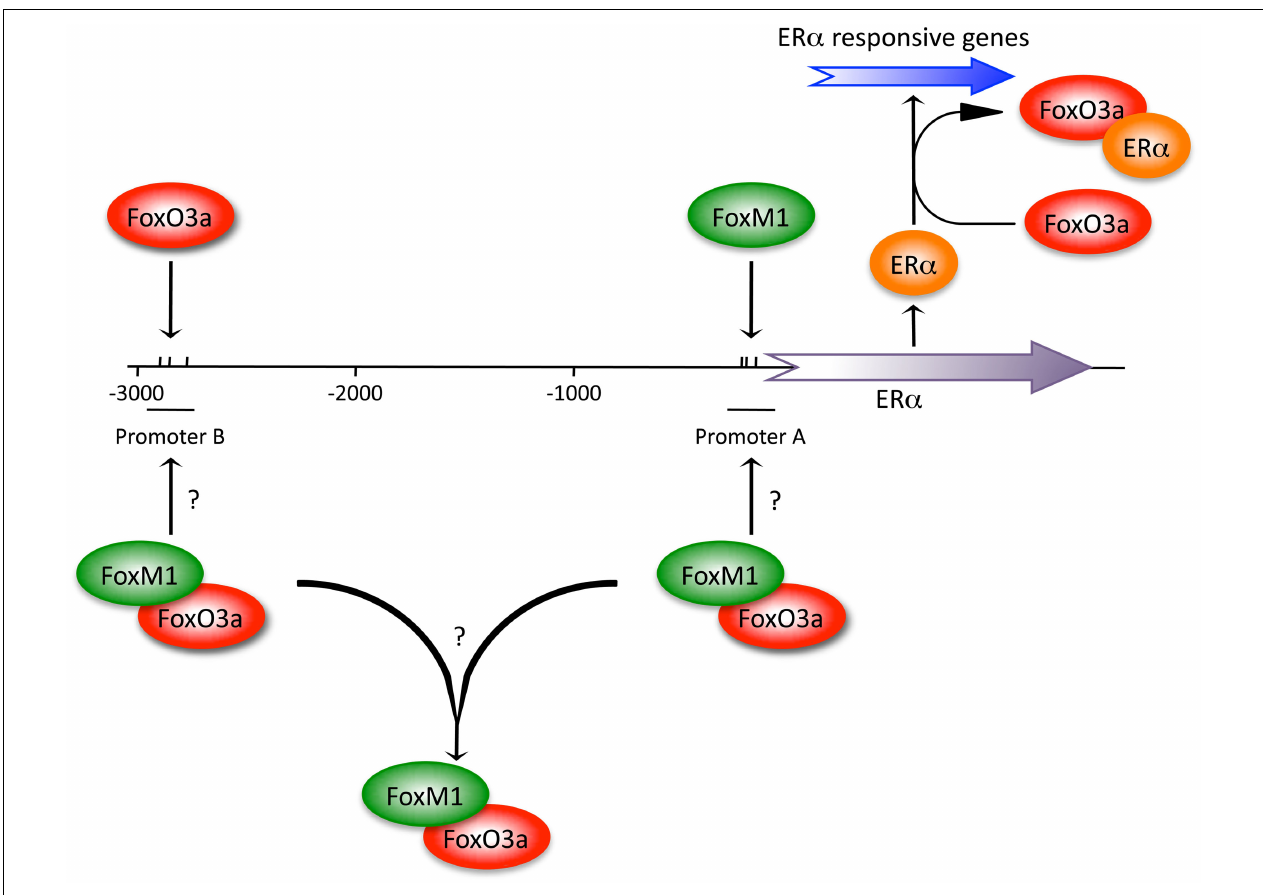
with FoxM1 playing a dominant role. A second level of complexity involves a protein/protein interaction between FoxO3a and ER α that blocks ER α from promoting the transcription of ER α responsive genes. A potential FoxO3a/FoxM1 physical interaction provides a third possible layer of complexity.The relevance of the FoxO3a/FoxM1 interaction remains unknown.This figure is based on work by Zou et al. (2008) and Madureira et al.